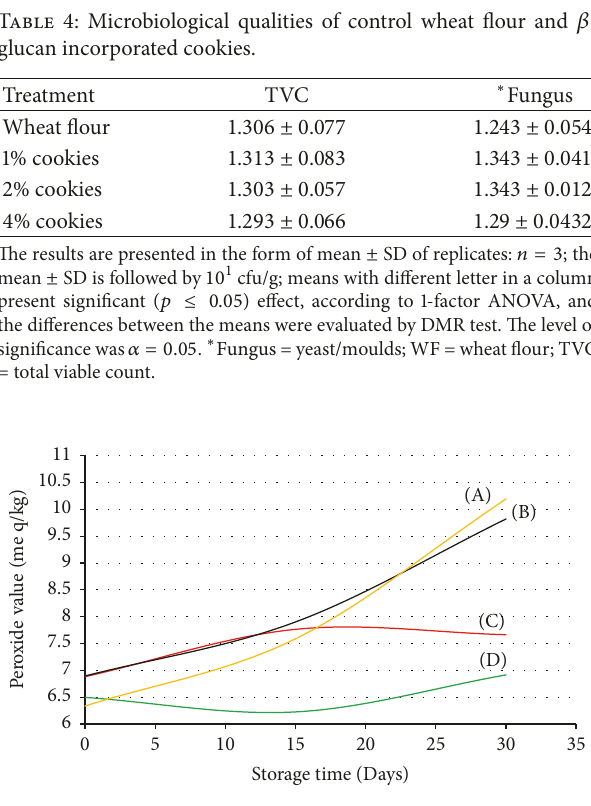
Figure 1: Peroxide value of cookies versus storage time (days). Control cookies (A); 1% 𝛽 -glucan made cookies (B); 4% 𝛽 -glucan made cookies (C); 2% 𝛽 -glucan made cookies (D).